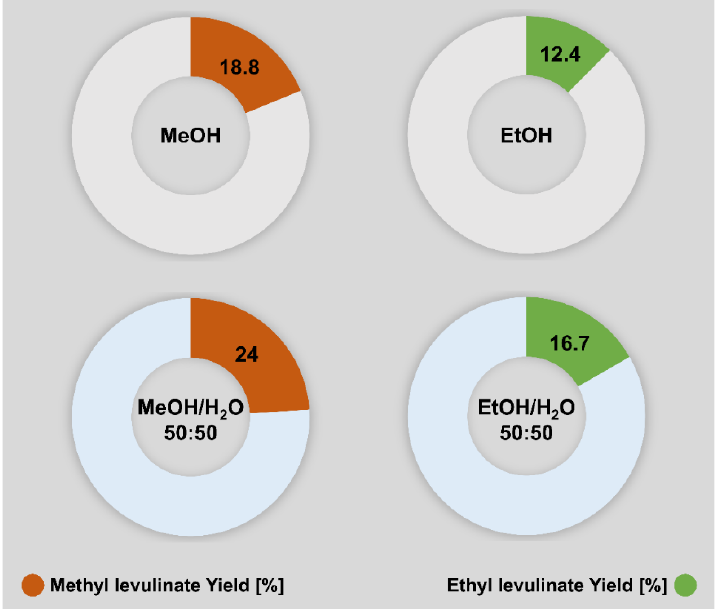
Figure 7. Co-solvent effect of HTC reaction temperature on the production of alkyl levulinates (Reaction conditions: 20 g of OPW; temperature: 180 °C; time: 60 min; autogenous pressure; stirring: 600 rpm).